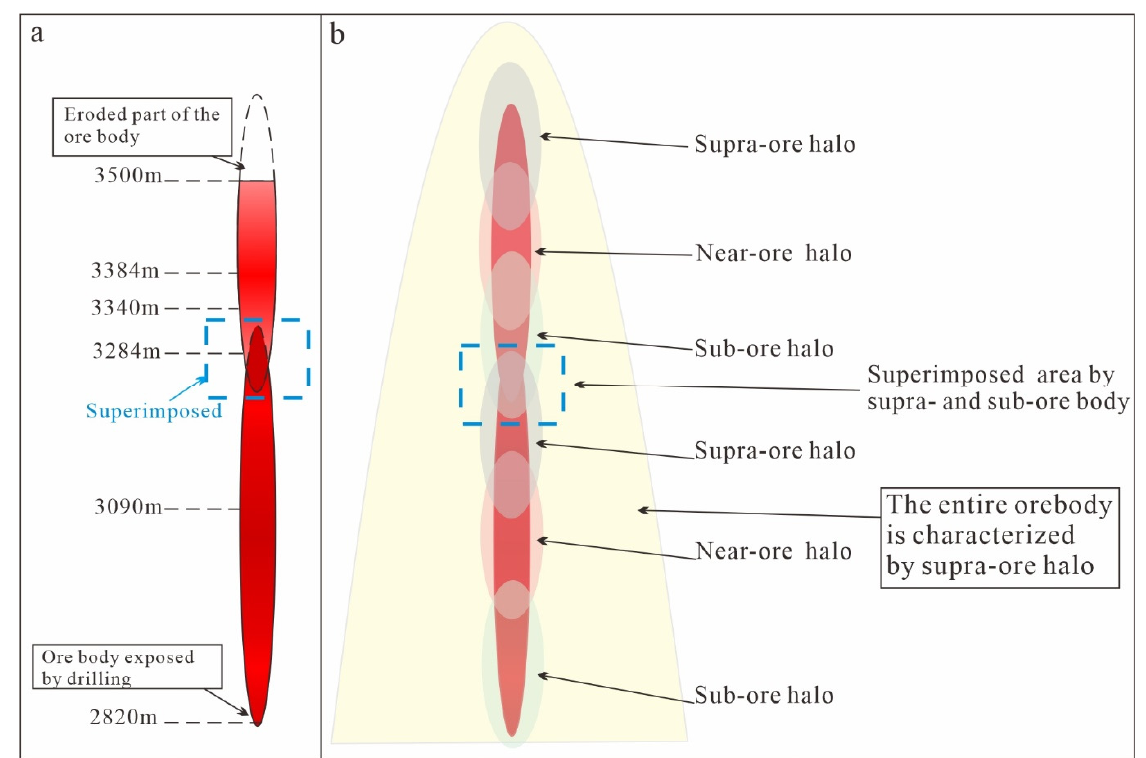
Figure 12. Schematic vertical section of the Yanjingou gold deposit. ( a ) The ore body were studied vertically from top to bottom and were divided into two small ore bodies; ( b ) Each independent small orebody conforms to the zoning criterion of primary halo, and for the whole orebody, it shows the characteristics of supra-ore hale.